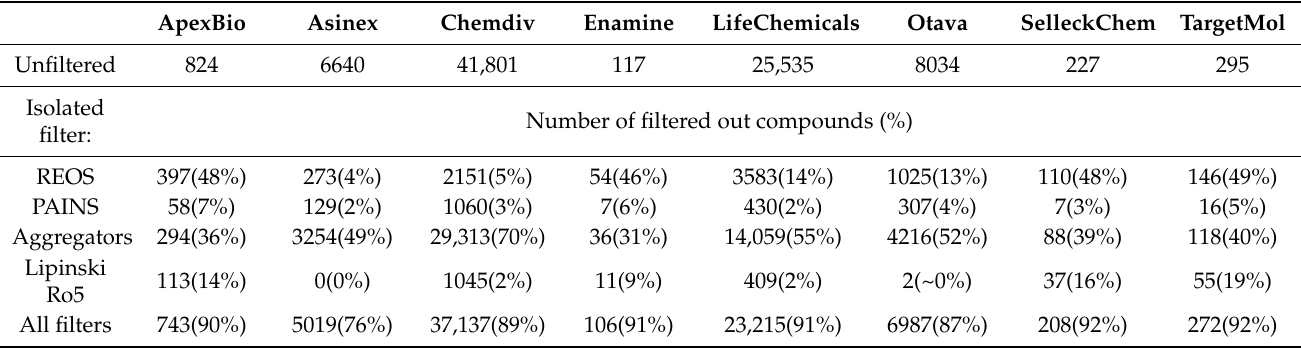
Table 5. Analysis of the attrition rate of various filters for the protease-inhibitor-targeted